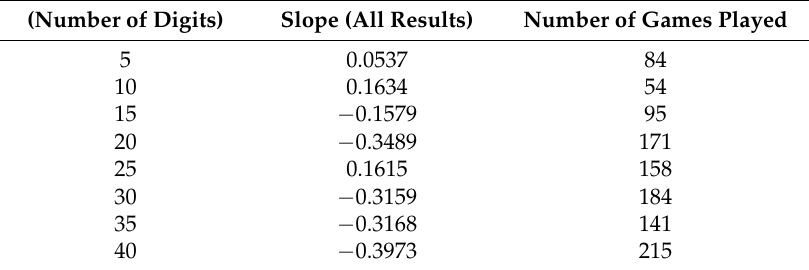
Table 1. Gaming on different levels in TMT (in